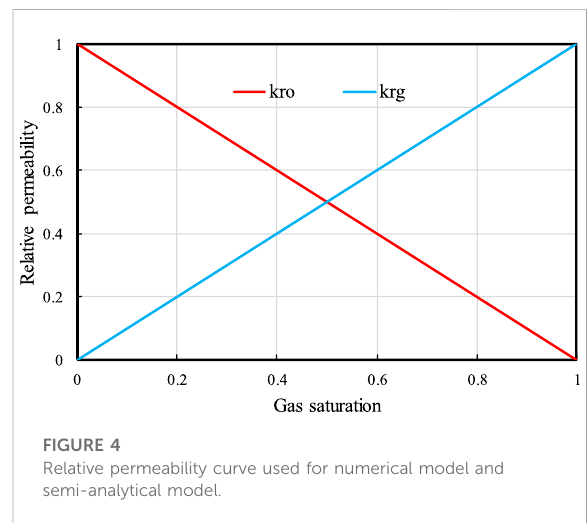
FIGURE 4 Relative permeability curve used for numerical model and semi-analytical